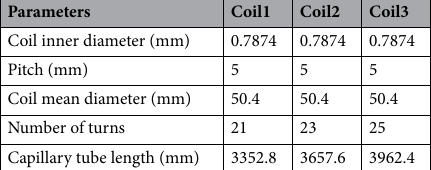
Table 4. Geometrical parameters of capillary coils.